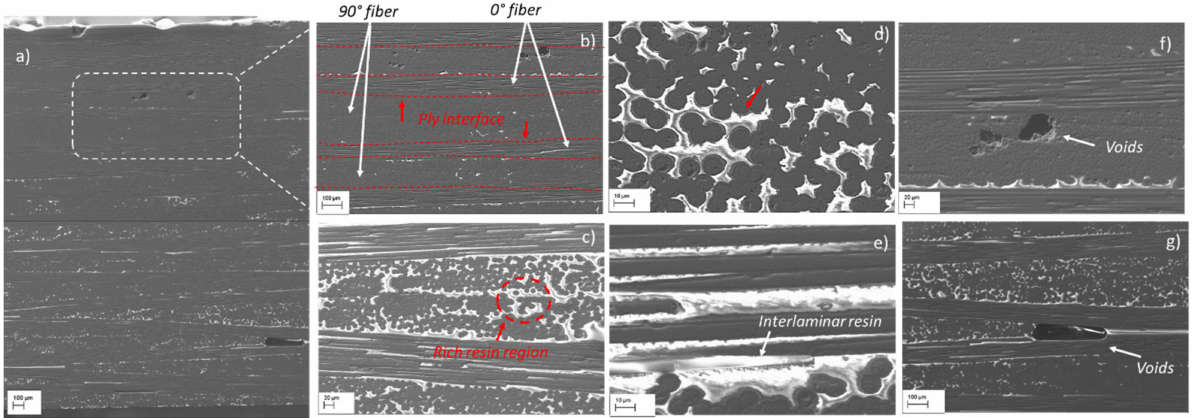
Figure 3. ( a ) SEM images of the mechanically polished cross-section of as-received sample and micrographs at different magnification; ( b ) lay-up configuration [0/90/0]; ( c ) parts of two of the laminae showing the rich-resin region; ( d ) fibres perpendicular (90 ◦ ) to the plane of the reference; ( e ) fibres along the reference plane (0 ◦ ); ( f ) small random shaped voids; ( g ) thin void layers (the relatively bright parts are the